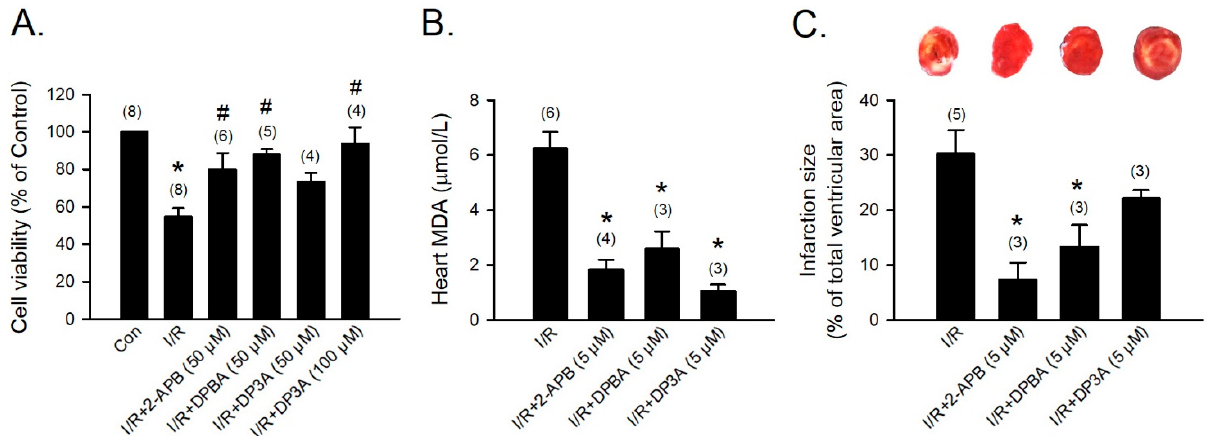
Figure 6. Protective effects of 2-APB, DPBA, and DP3A on the I/R-induced cell death, myocardial infarction, and lipid peroxidation. ( A ) 2-APB, DPBA, and DP3A inhibited the I/R-induced cell death. Isolated adult rat cardiomyocytes were exposed to ischemia for 30 min, followed by 2 h reperfusion with 2-APB, DPBA, or DP3A. MTT assay was used to determine cell viability. * p < 0.05 different from control; # p < 0.05 different from the I/R group. ( B ) 2-APB, DPBA, and DP3A inhibited lipid peroxidation after I/R. * p < 0.05 different from the I/R group. ( C ) 2-APB and DPBA, but not DP3A, decreased myocardial infarct size induced by I/R. Isolated rat hearts were perfused by a Langendorff system. The hearts were stable for 20 min, and then exposed to 30 min ischemia followed by 1 h reperfusion with 2-APB, DPBA, or DP3A. Myocardial infarct size was determined by Triphenyl tetrazolium chloride (TTC) staining. The infarct size was expressed as a percentage of left ventricular volume for each heart. * p < 0.05 different from the I/R group. Values shown in parenthesis represent the number in each group. Data are expressed as mean ± SEM. Abbreviations: I/R, ischemia/reperfusion; MDA,